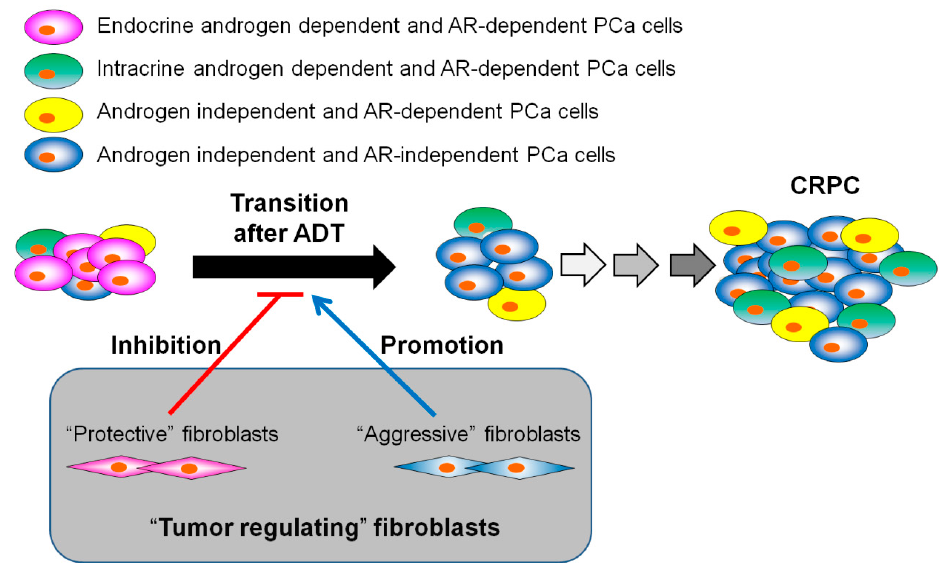
Figure 2. “Tumor regulating fibroblasts” and the role of fibroblasts after ADT in PCa patients. “Protective” fibroblasts inhibit the transition of PCa cells from AR-dependent to AR-independent, whereas “aggressive” fibroblasts promote the transition from AR-dependent to AR-independent [7].